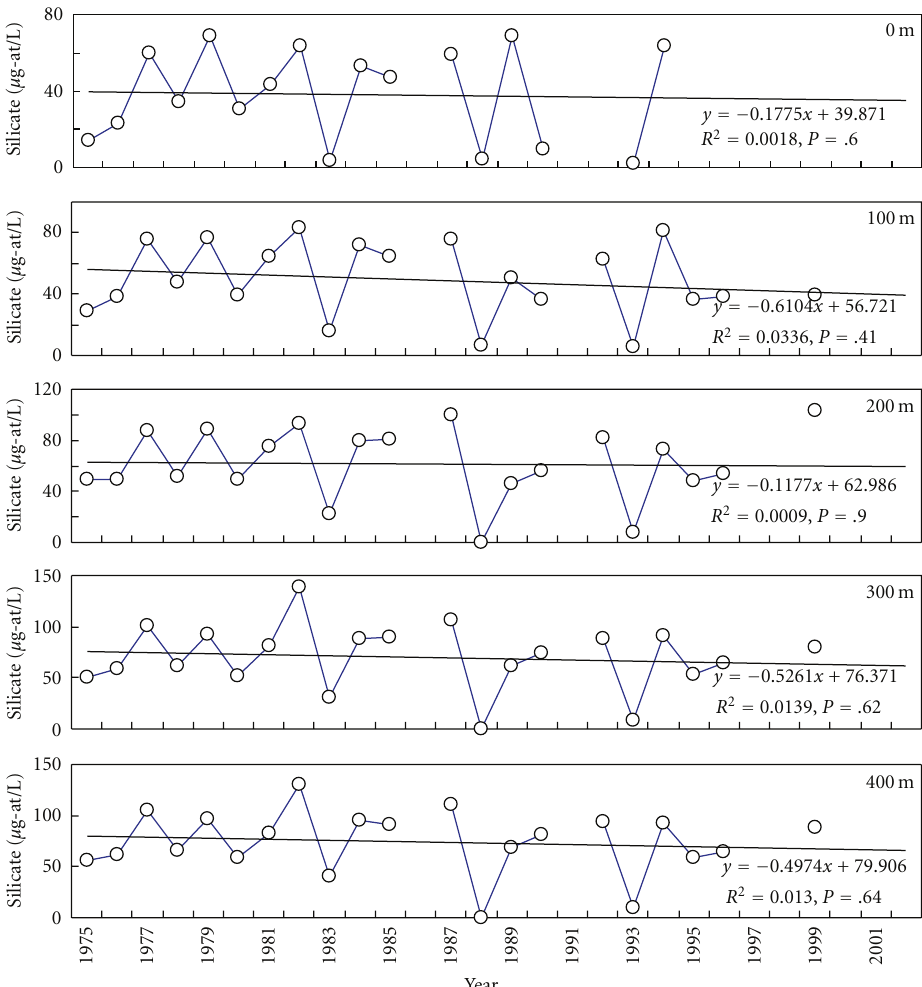
Figure 10: Long-term time series of the mean sea water silicate concentrations at the surface, 100m, 200 m, 300 m, and 400m during austral summer (January–March) between 1975 and 2002. Solid lines represent linear